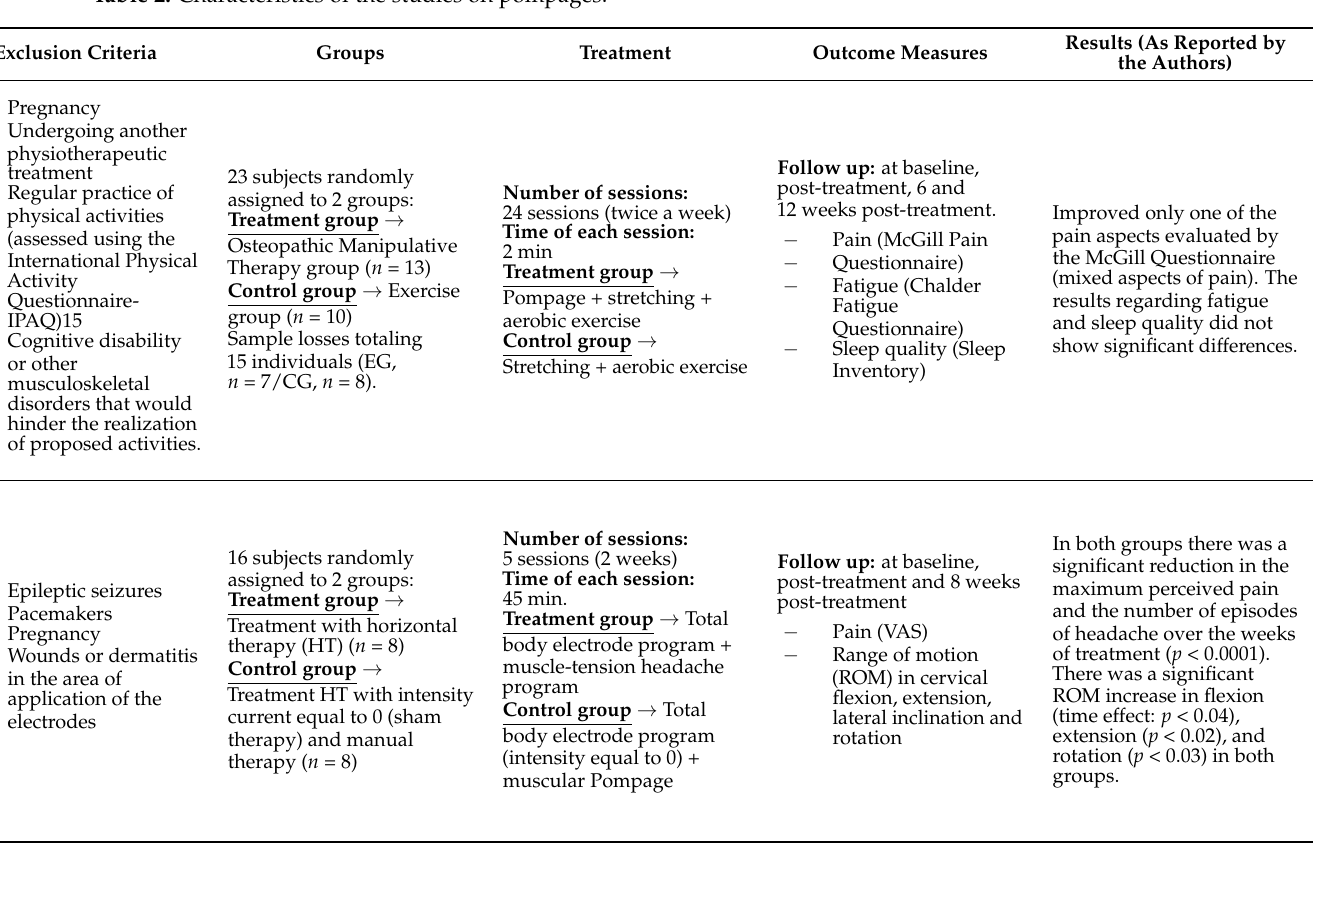
Table 2. Characteristics of the studies on